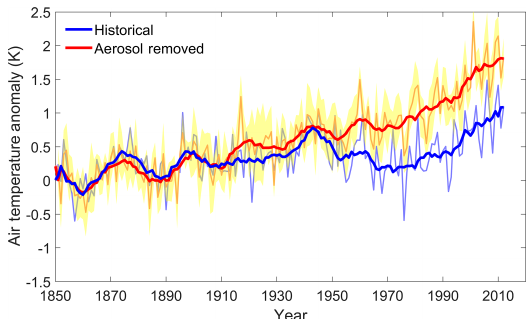
Figure 8. Temporal annual variation in air temperature, and air tem- perature with the depressing effect of aerosols removed in the sum- mer season. The shaded area is the standard deviation of the model average.